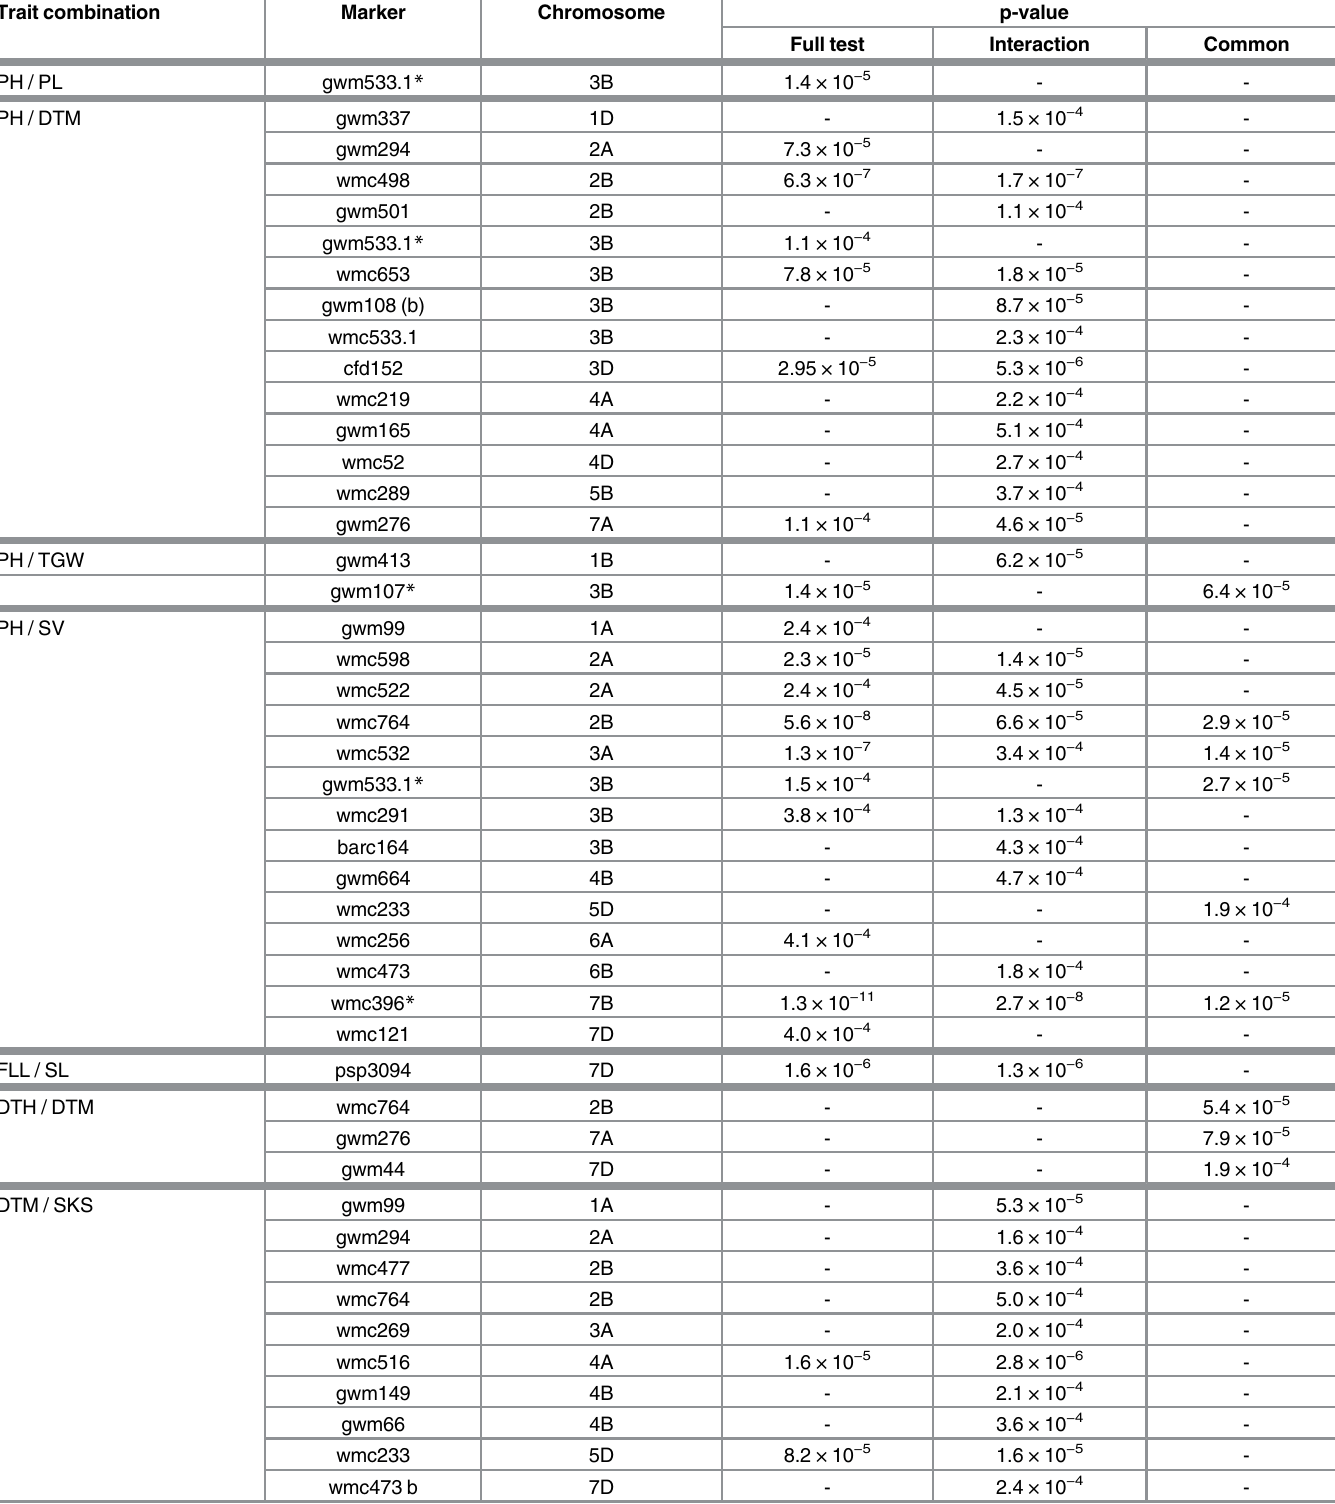
Table 5. Significant marker-trait associations identified through multi-trait mixed model (MTMM) and qualified FDR criteria. MTMM was performed for pair of correlated traits (for significant and high correlation; p value (cid:1) 0.05, r 2 value (cid:3)